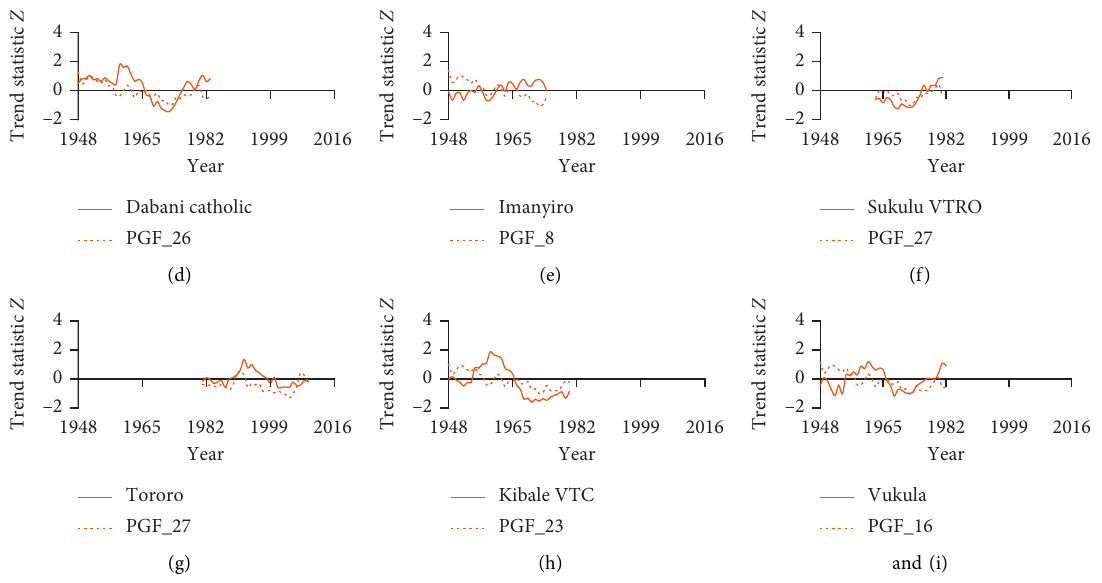
Figure 12: Variability of OND PGF and observed rainfall at stations (a) 1, (b) 2, (c) 3, (d) 4, (e) 5, (f) 6, (g) 7, (h) 8, and (i) 9.